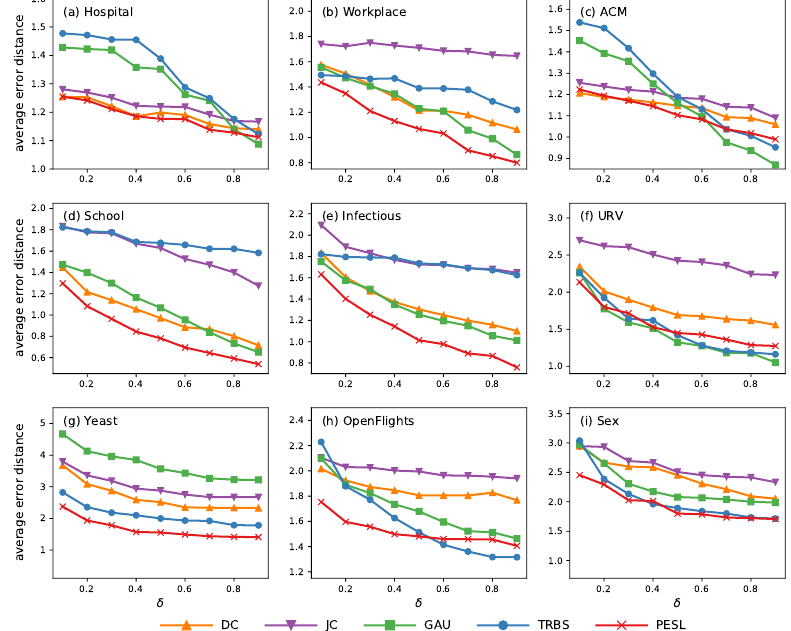
Figure 8. The performance of epidemic source localization accuracy in empirical networks under various reporting probabilities with five algorithms. ( a – i ) represent the results in Hospital, Workplace, ACM, School, Infectious, URV, Yeast, OpenFlights and Sex network respectively. In the figure, the abscissa represents the reporting probability of nodes δ , the ordinate denotes the distance between the real source and the source found by different source localization algorithms. The number of observers is similar to Figure 7. The infection probability used in the simulation was β = 0.2 and the recovery probability was γ =